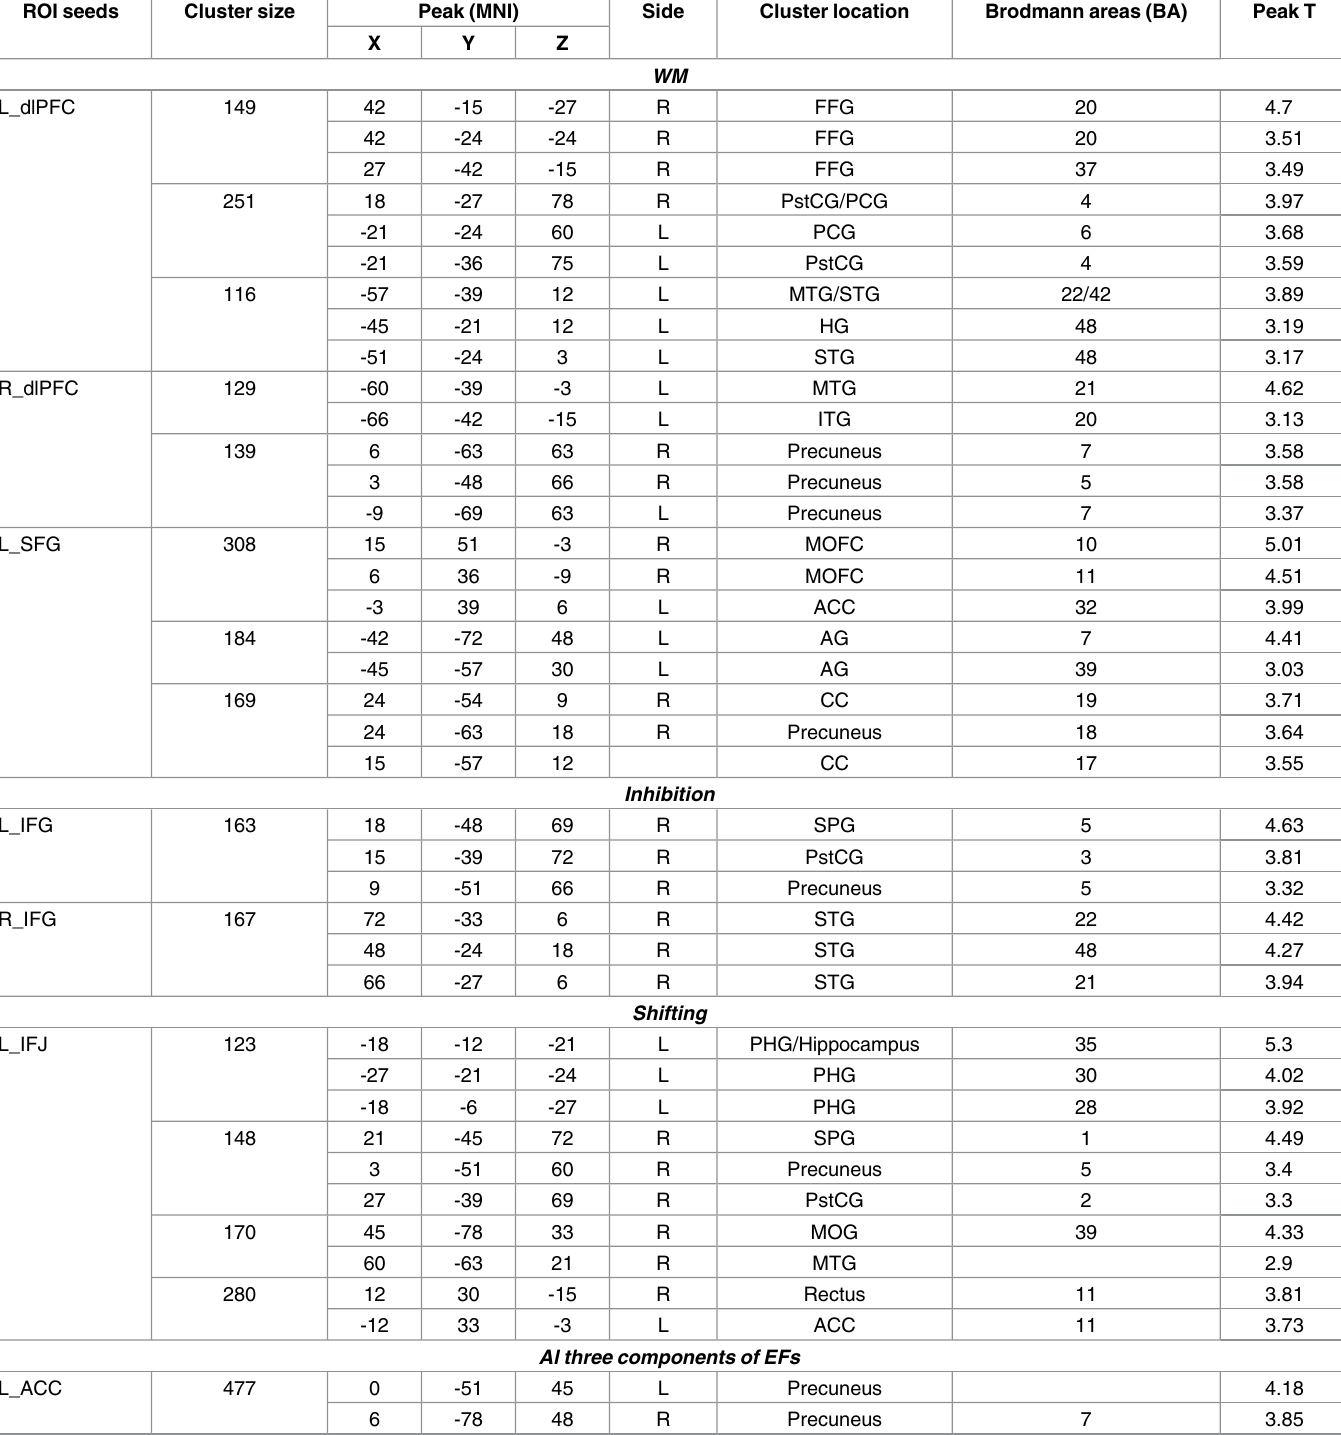
Table 4. Brain areasshowing stronger RSFC among CCH participants than controls based on ROI seeded FC analyses with topological FDR (p < 0.01) correction. ROI